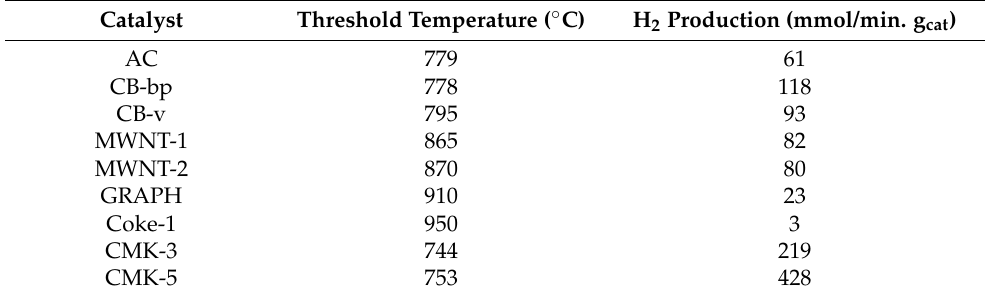
Table 14. A comparison to show the order of catalytic activity of tested carbonaceous catalysts from ref.